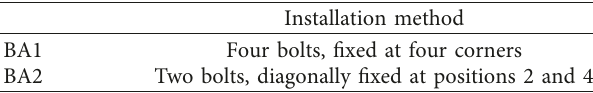
Figure 9: SEM image of the EMWM (100x enlargement). Table 4: Installation methods of